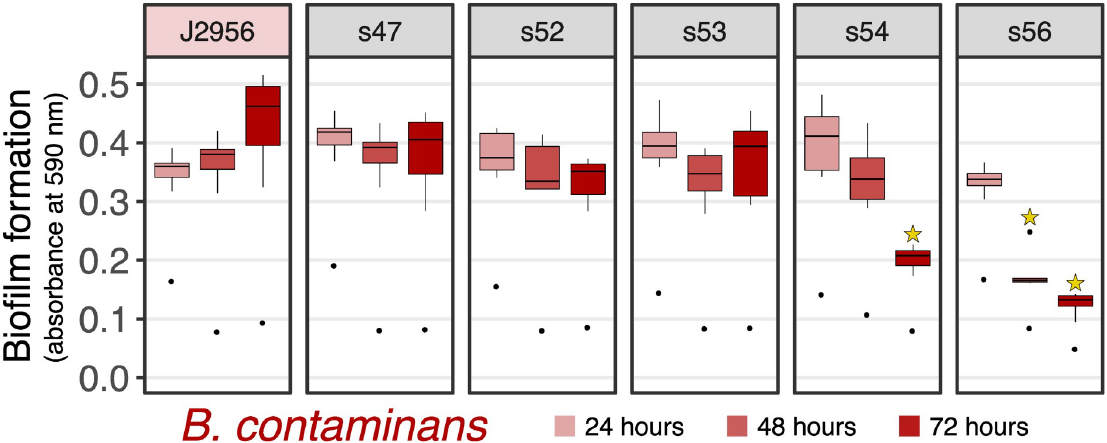
Fig 11. Biofilm formation of B . contaminans . Same as Fig 9. Stars indicate < 0.04 adjusted p-value from two-sided t-tests against the reference strain (adjusted by Bonferonni correction).